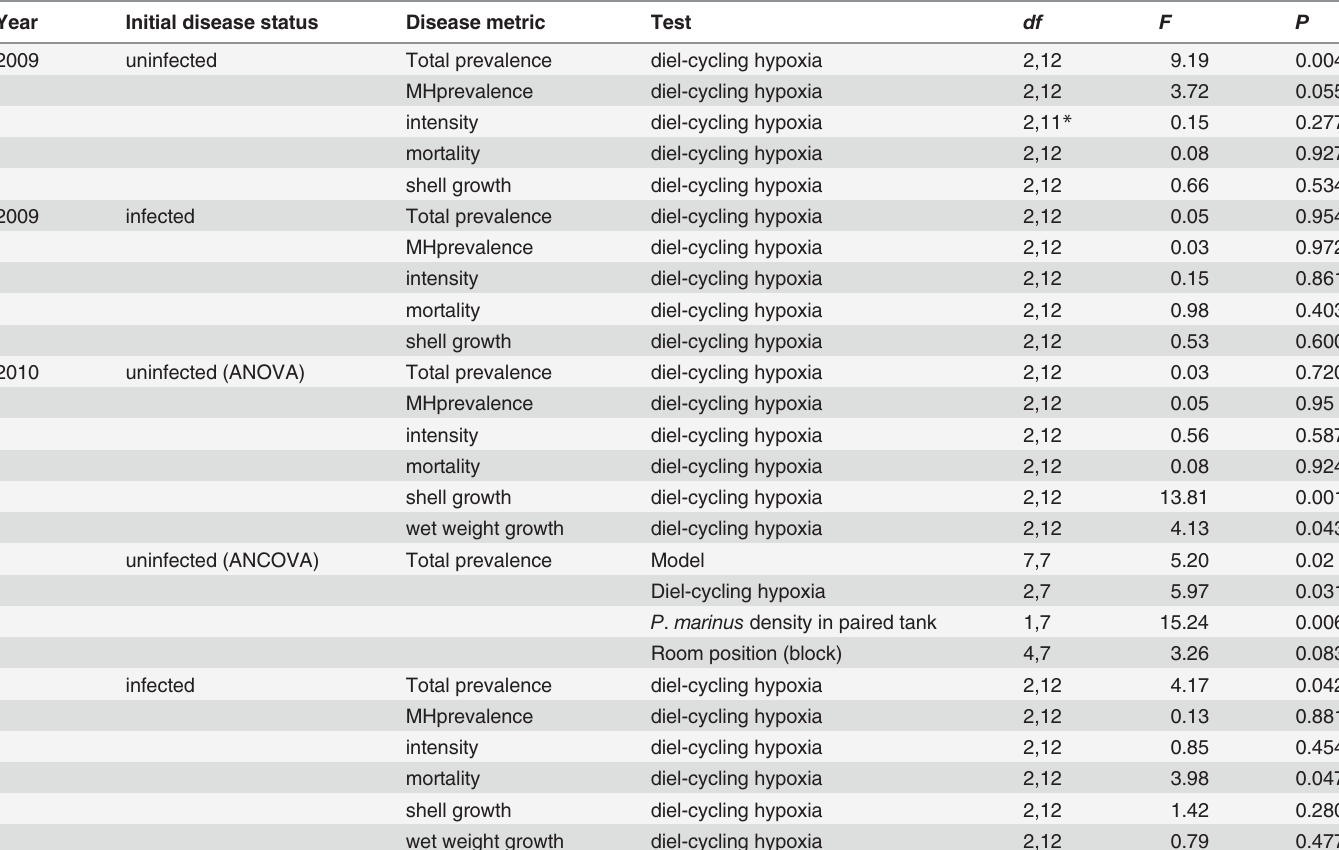
Table 4. Results of laboratory experiment statistical